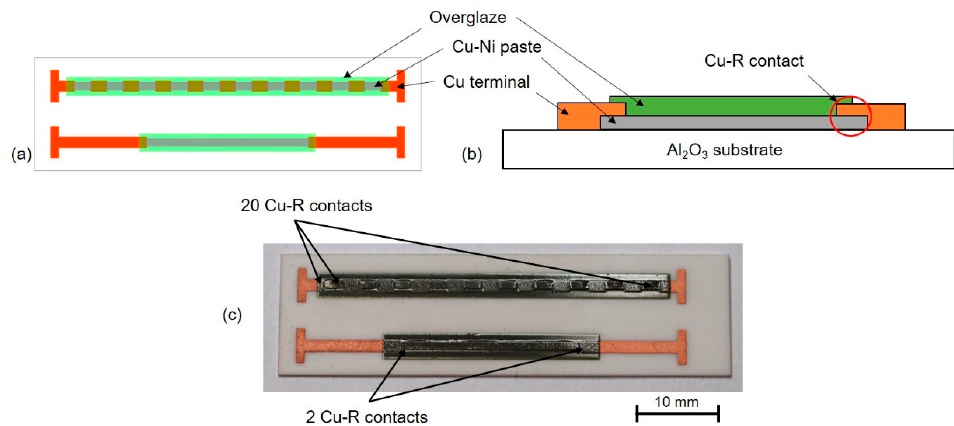
Figure 1. ( a ) IRP design, ( b ) schematic section of the printed resistor and ( c ) realized IRP